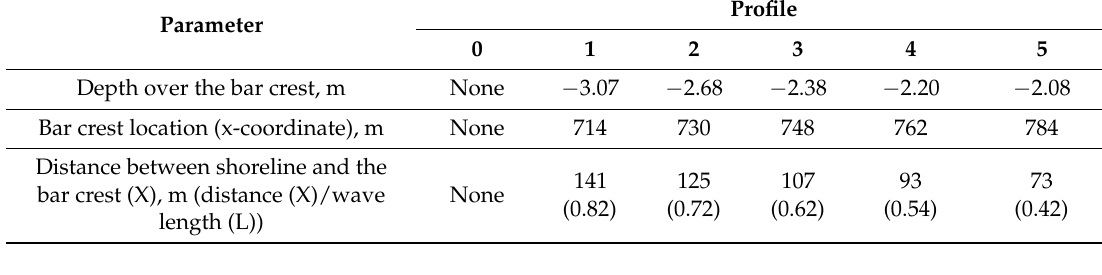
Figure 2. The cross-shore profiles used as the model bathymetry input. Table 1. Parameters of the initial profiles.